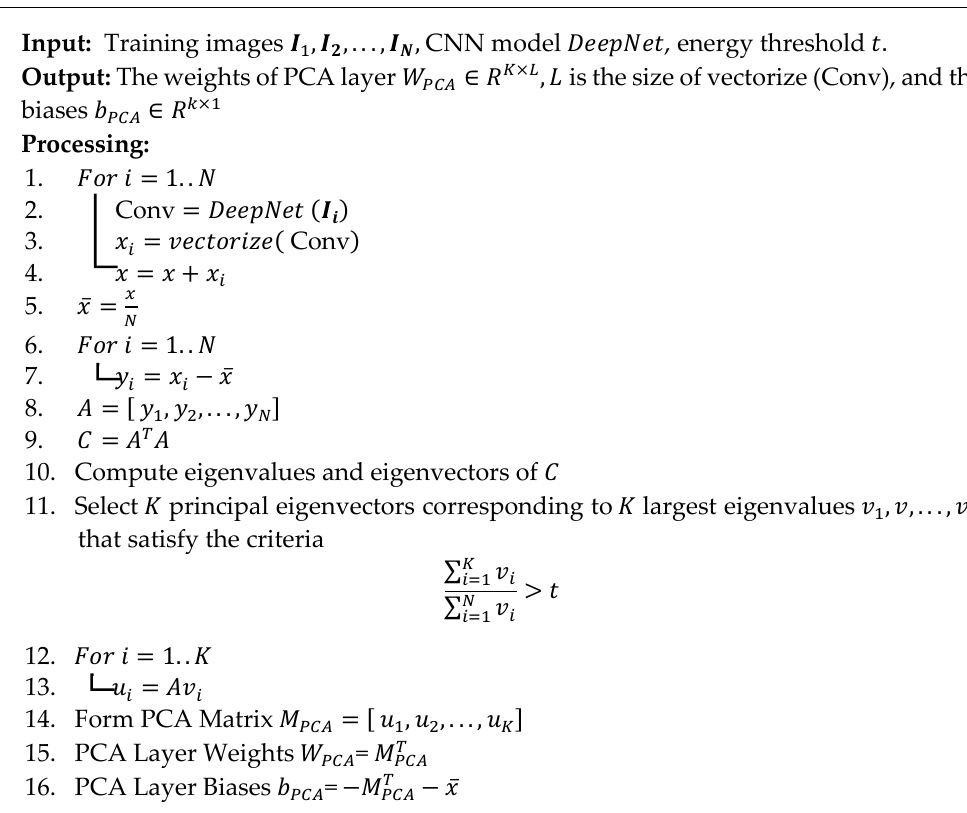
Algorithm 2: LDA Layer—Weights